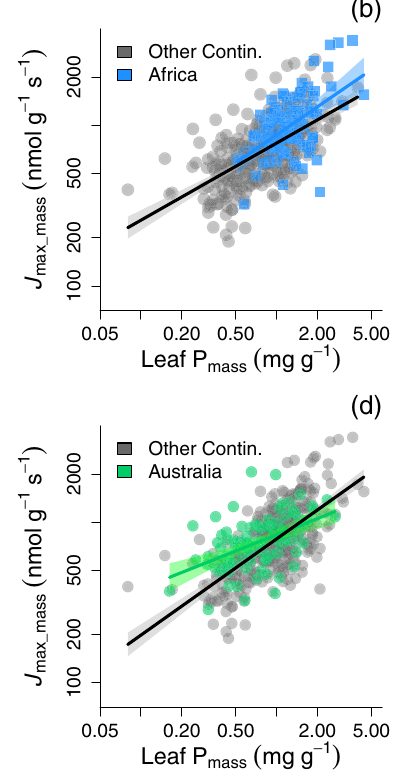
Fig. 2 | Comparison of J max_mass as a function of P mass for woody species on different continents. Each continent is shown compared to the full remainder of the dataset (denoted ‘ Other Continents ’ ), for a South America, ( b ) Africa, ( c ) Asia, ( d ) Australia). Each point denotes a different species-site mean. There was no